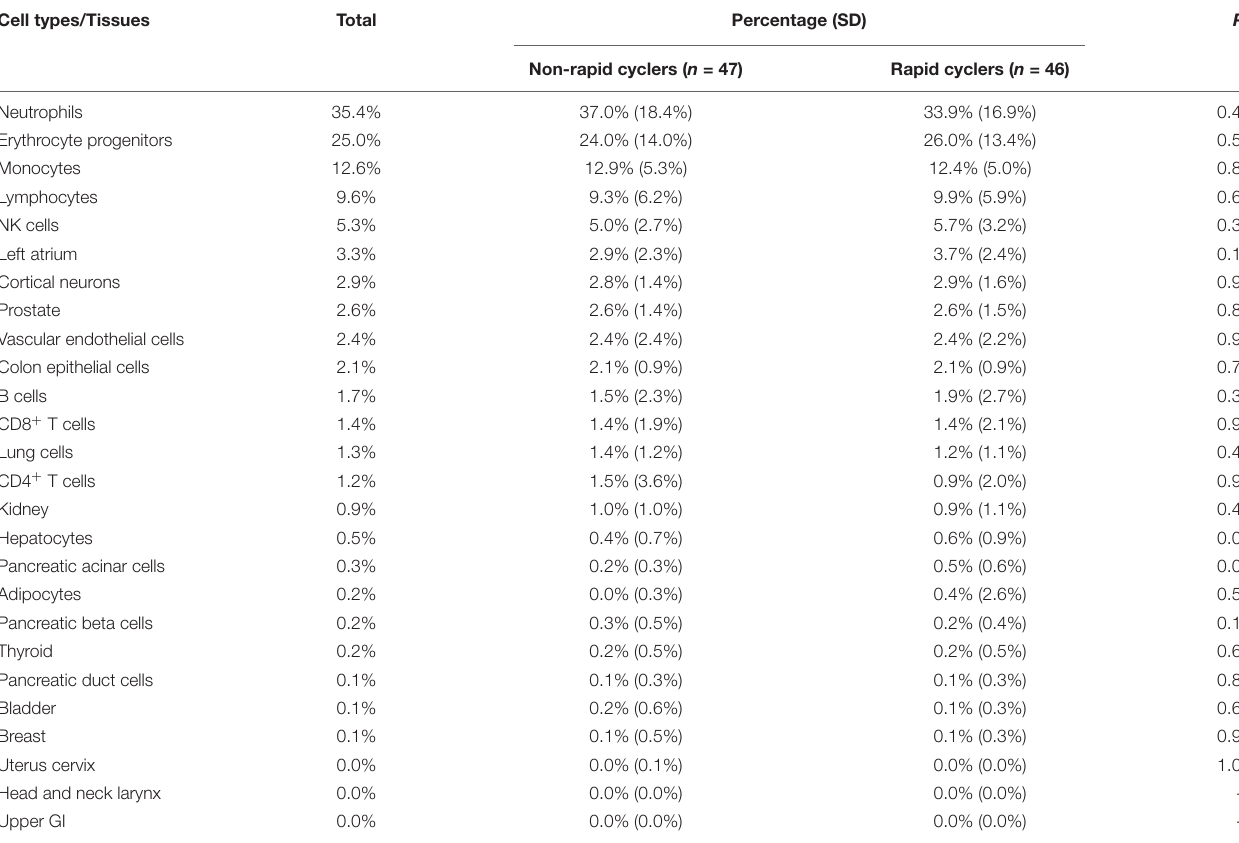
TABLE 2 | Comparison of estimated cfDNA tissue/cell type origin distribution between BD rapid cyclers and non-rapid cyclers. Cell